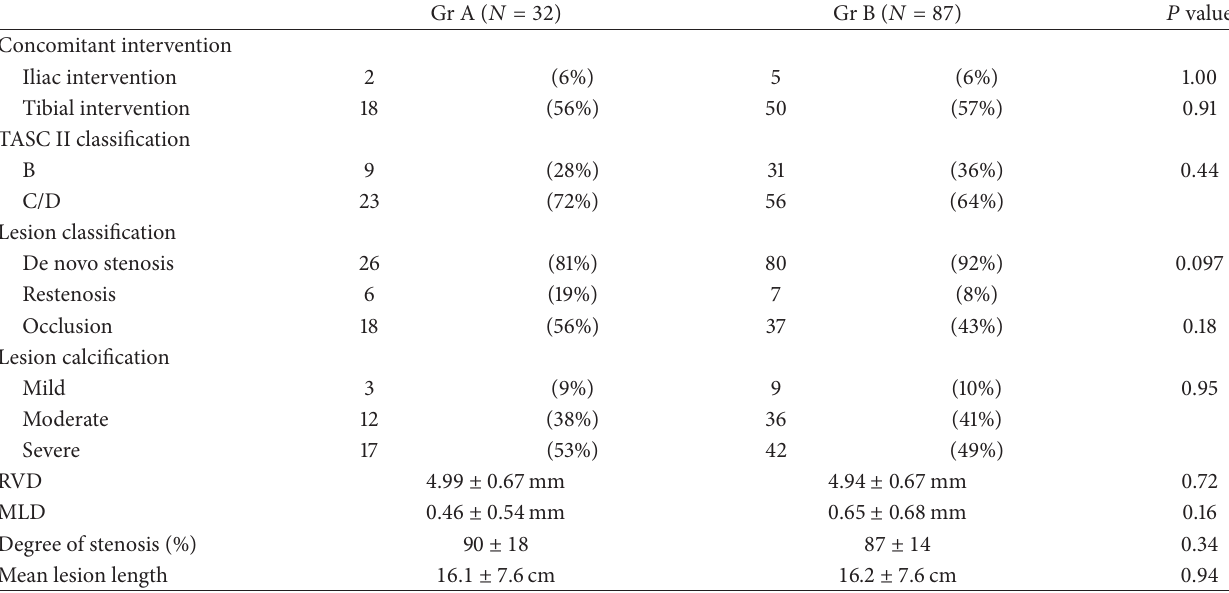
Table 2: Baseline lesion characteristics of femoropopliteal